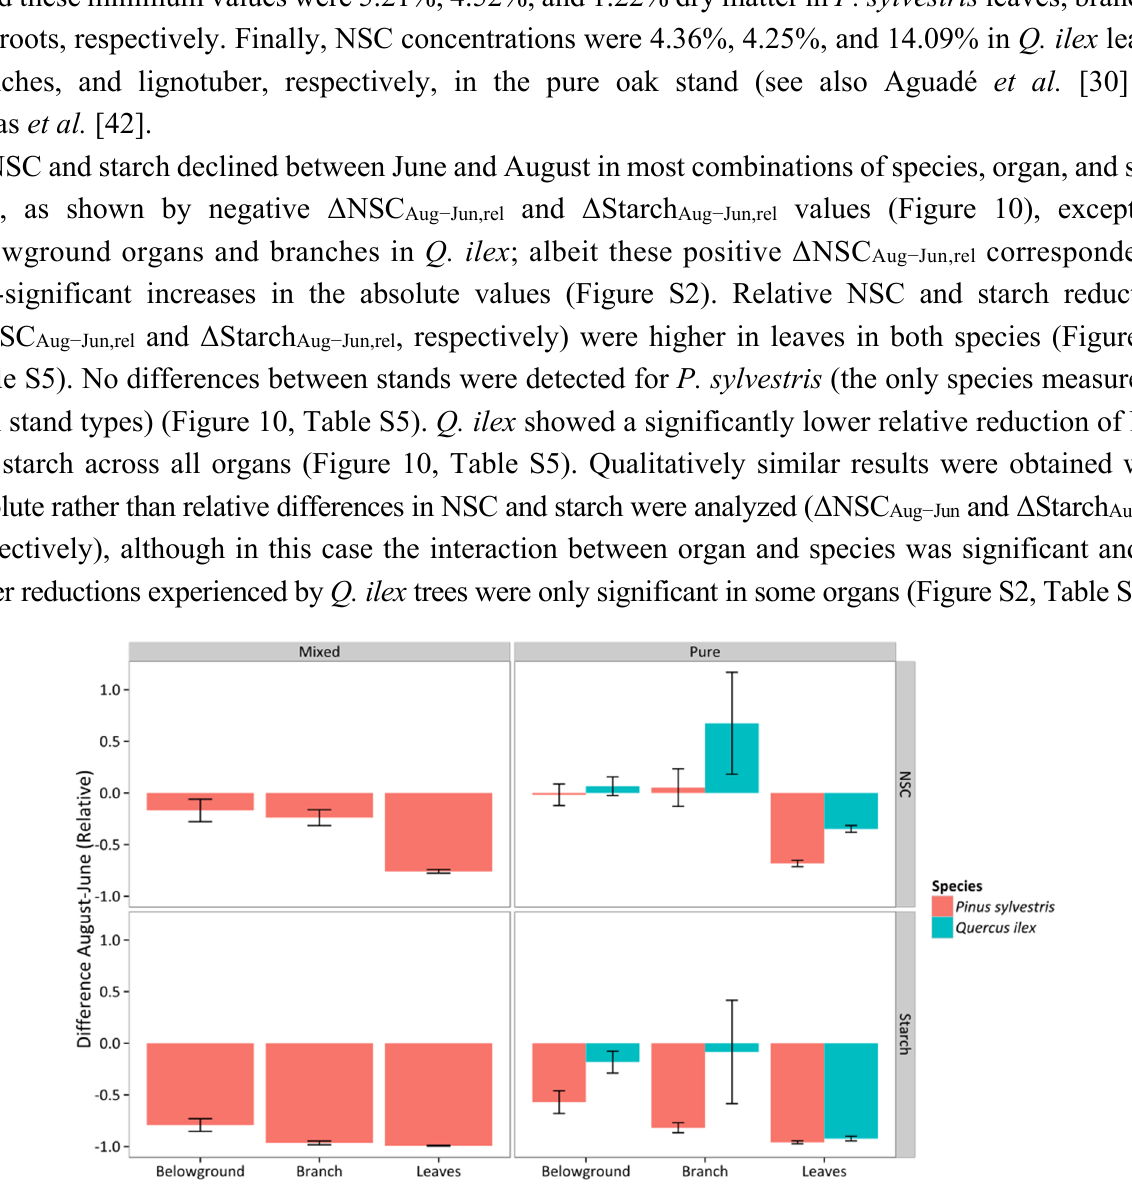
Figure 10. Relative difference between August and June in measured total non-structural carbohydrates ( Δ NSC Aug − Jun,rel , upper panels) and starch ( Δ Starch Aug − Jun,rel , bottom panels). Values are given for different organs, stand types (columns), and species. Average values for P. sylvestris and Q. ilex trees are shown. Error bars indicate ±1